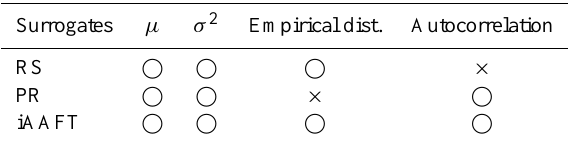
Table 1. Comparison of the statistics of the original data with that of the surrogate data. µ : mean, σ 2 : variance. (cid:13) : preserved, × : not preserved.